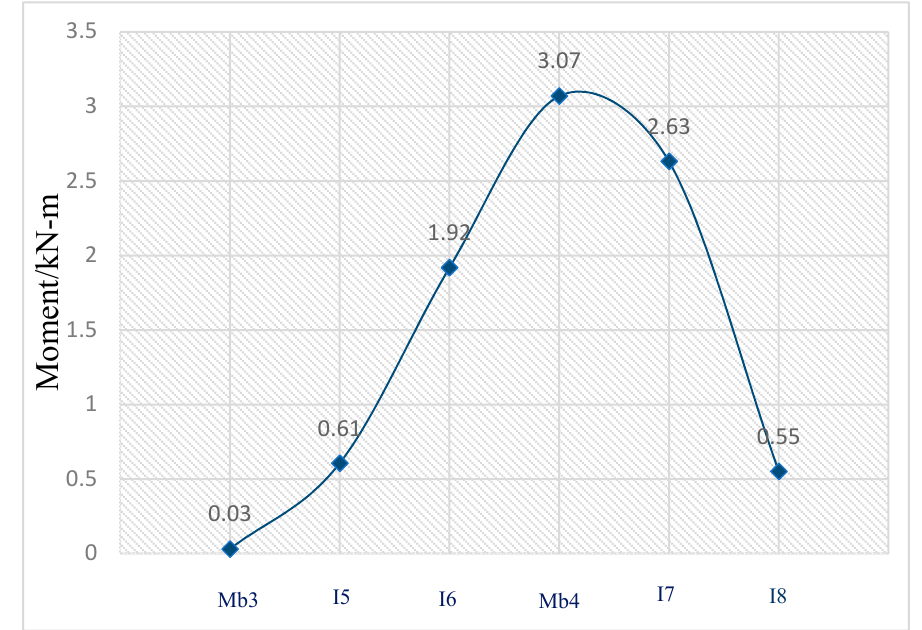
Figure 10. Moment distribution along the midspan.